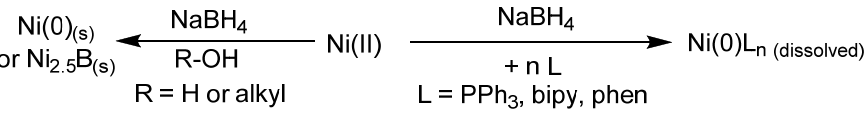
Figure 1. The structures of broadly used ligands of nickel complexes catalytically active for HDH [61–67]. Scheme 8. Ni(PEt 3 ) 2 Cl 2 catalyzed HDC of polychlorinated biphenyls in THF Scheme 8. Ni(PEt 3 ) 2 Cl 2 catalyzed HDC of polychlorinated biphenyls in THF [59].